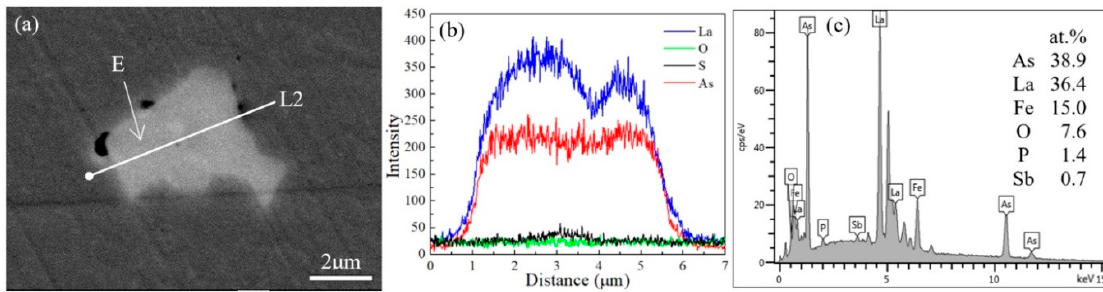
Figure 4. Morphologies and chemical compositions of (La-S-As)-(La-As) inclusions. ( a ) Morphologies of inclusions; ( b ) EDS of position B; ( c ) EDS of position C; ( d ) EDS of position D.